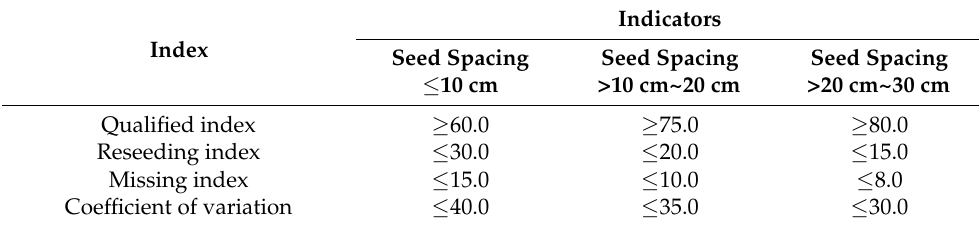
Table 2. Main performance indices of the precision